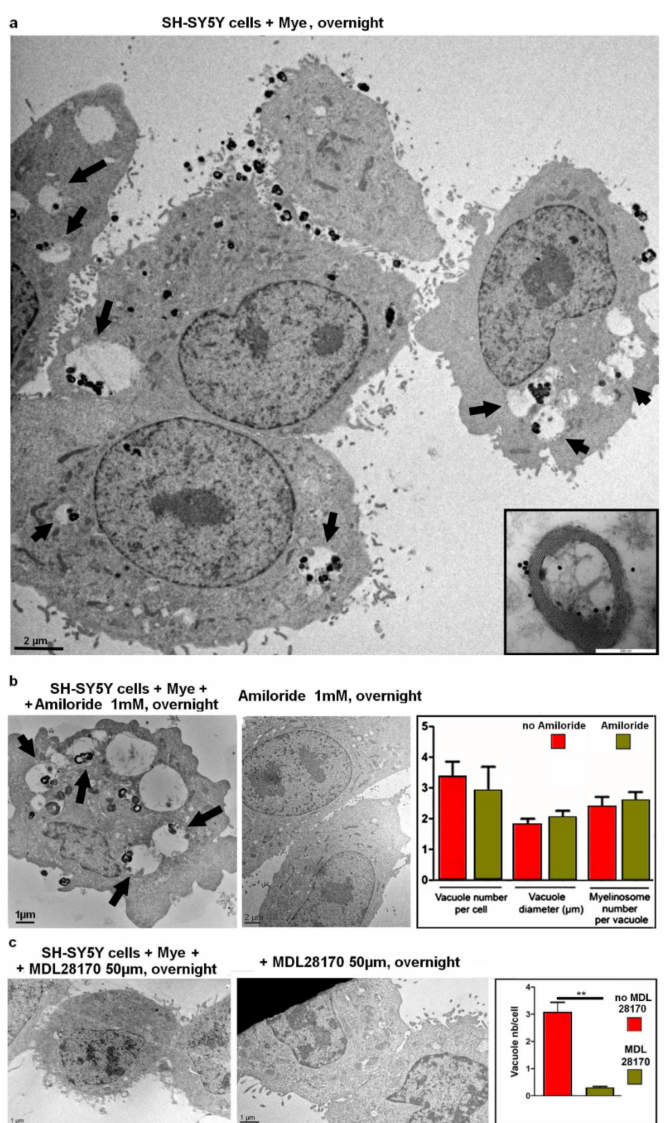
Figure 5. Incorporation of myelinosomes into SH-SY5Y cells is inhibited by synthetic drug MDL28170. ( a ) Electron micrograph of SH-SY5Y cells after overnight exposure to myelinosomes carrying EGFP- mHTT-exon1. Note that incorporated myelinosomes are found in cytoplasmic vacuoles (arrows). Selection in right corner is anti-EGFP immunogold labeling of the myelinosome preparation used in this experiment. ( b ) Electron micrograph showing amiloride-pretreated SH-SY5Y cells after overnight incubation with myelinosomes loaded with EGFP-mHTT-exon1 (left panel), and amiloride-pretreated SH-SY5Y cells, which were not exposed to myelinosomes (central panel). Arrows denote cytoplasmic vacuoles harboring myelinosomes. Quantification histogram (right panel) depicts the number of myelinosome-bearing vacuoles/per cell, the diameter of the vacuoles, and the number of myeli- nosomes per vacuole in amiloride-pretreated and untreated SH-SY5Y cells following overnight incubation with myelinosomes loaded with EGFP-mHTT-exon1. No significant variations were revealed. ( c ) Electron micrograph showing SH-SY5Y cells after overnight incubation with myeli- nosomes carrying EGFP-mHTT-exon1, in the presence of membrane fusion inhibitor MDL28170 (left panel) and MDL28170-pretreated SH-SY5Y cells, which were not exposed to myelinosomes (central panel). Quantification histogram (right panel) depicts the number of myelinosome-harboring vacuoles in SH-SY5Y cells in the presence or absence of membrane fusion inhibitor MDL28170. ** p < 0.001 by two-tailed Student’s t test. Abbreviations: